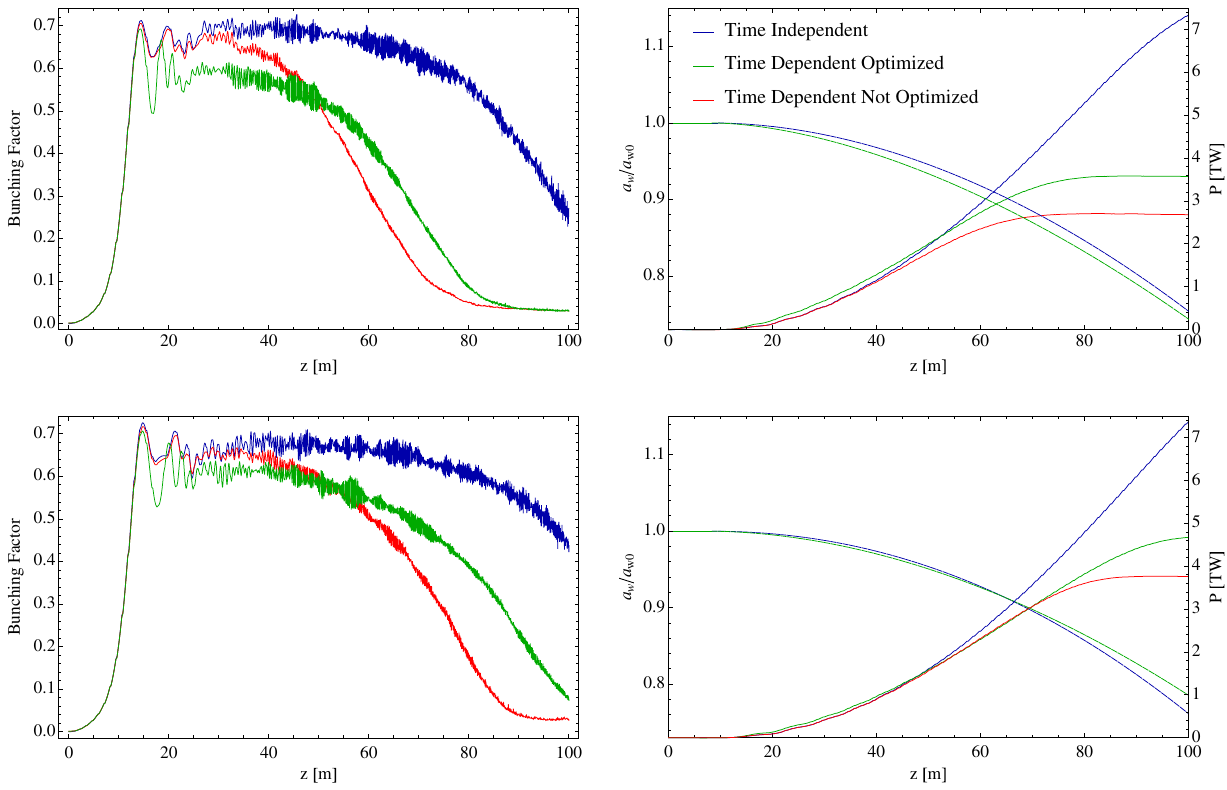
FIG. 3. Bunching factor (left), taper profiles and FEL radiation power evolution (right) obtained from time independent and time dependent optimization. The top plots correspond to an input energy spread σ E; 0 ¼ 3 . 1 MeV consistent with the SASE result from Fig. 1. The bottom plots are an alternate case with σ E; 0 ¼ 1 . 5 MeV. In both cases z ¼ 0 is after the self-seeding monochromator and the input seed power is 5